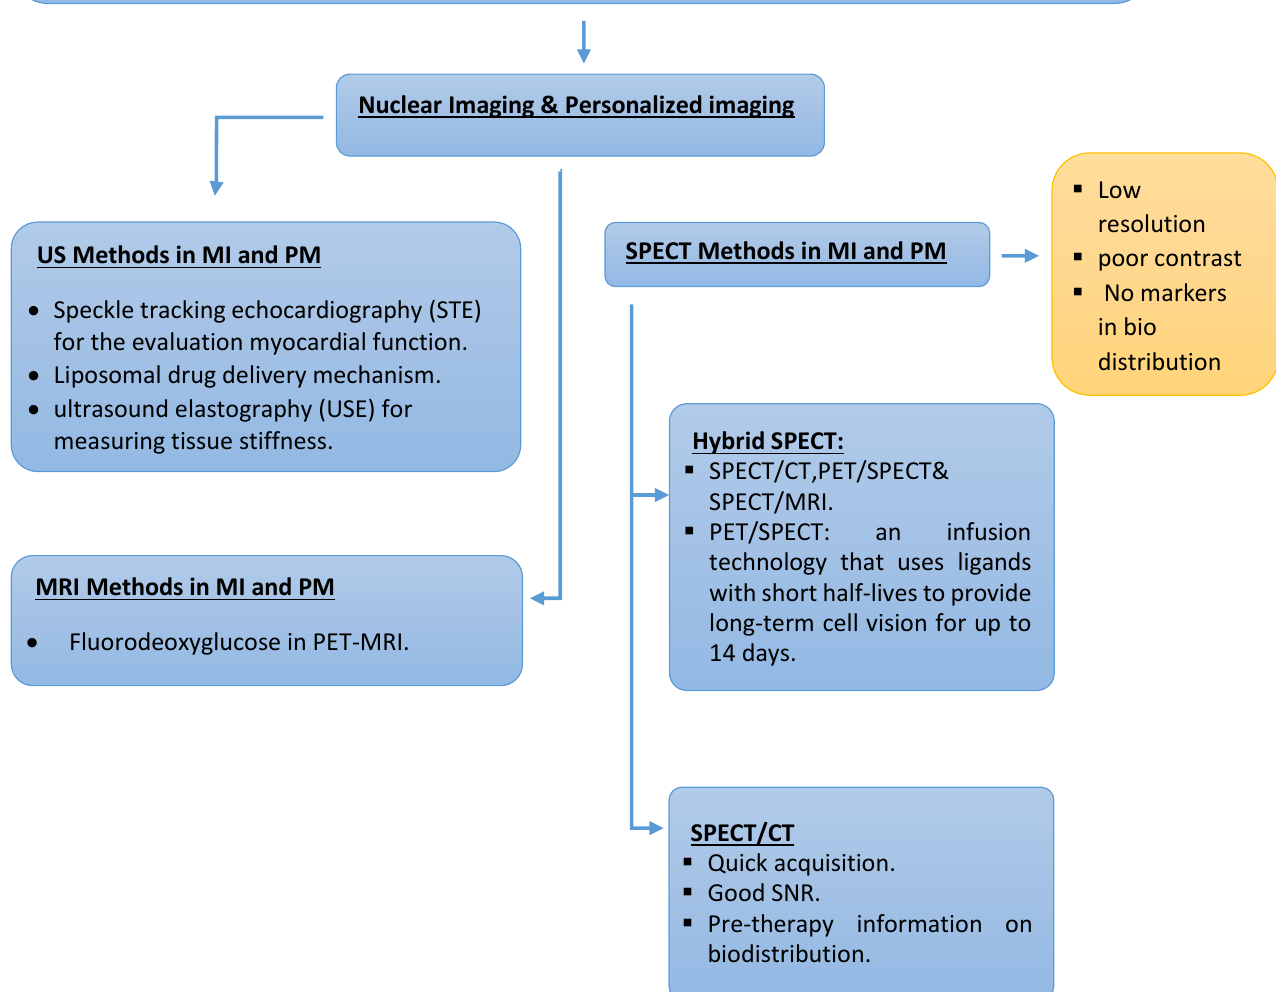
Figure 1. An improved knowledge of how a person’s particular molecular and genetic profile renders them prone to various diseases has resulted from scientific developments in customized medicine. The assessment of disease heterogeneity and progression planning, treatment, molecular features, and long-term follow-up are all common uses for molecular imaging techniques. The following illustration presents the key findings of this